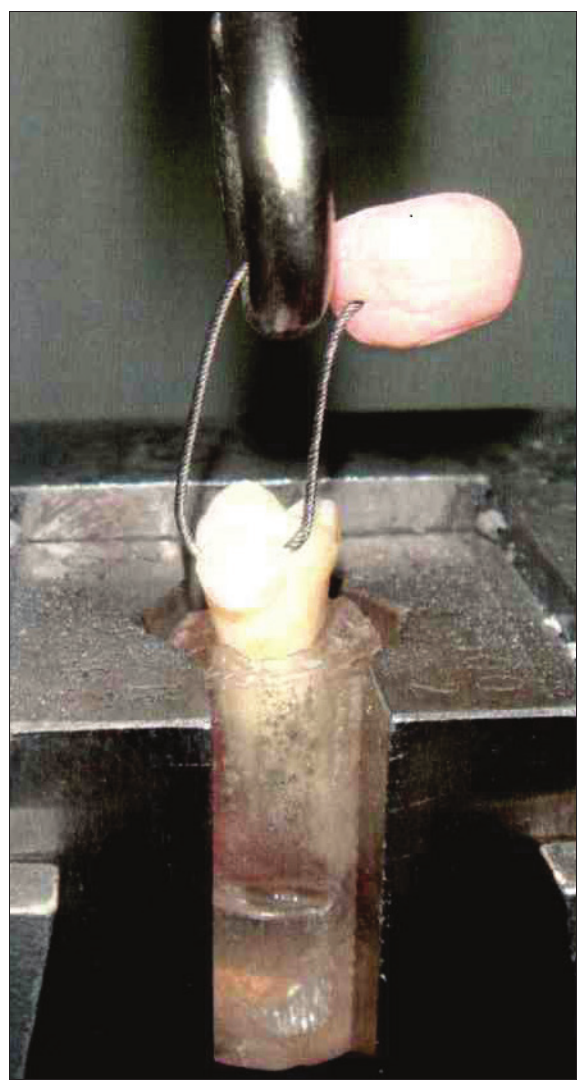
Figure 1. Bonded specimen loaded in the Instron